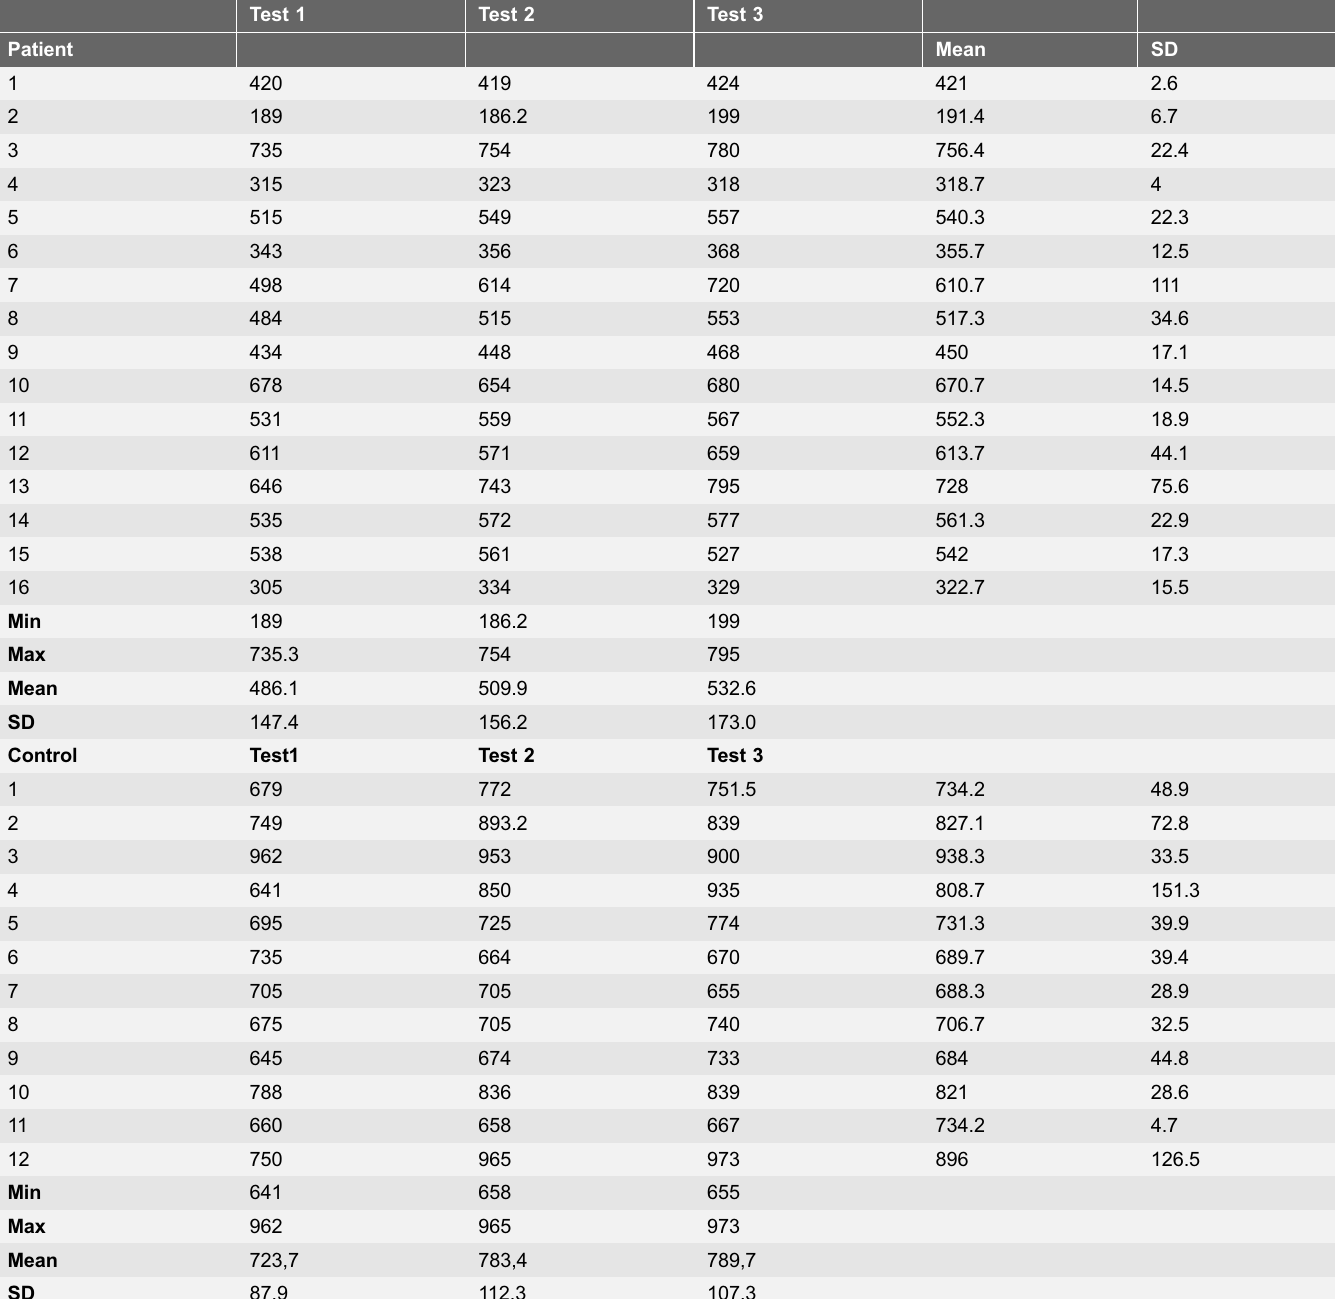
Table 2. Walked distance during each test for patients and